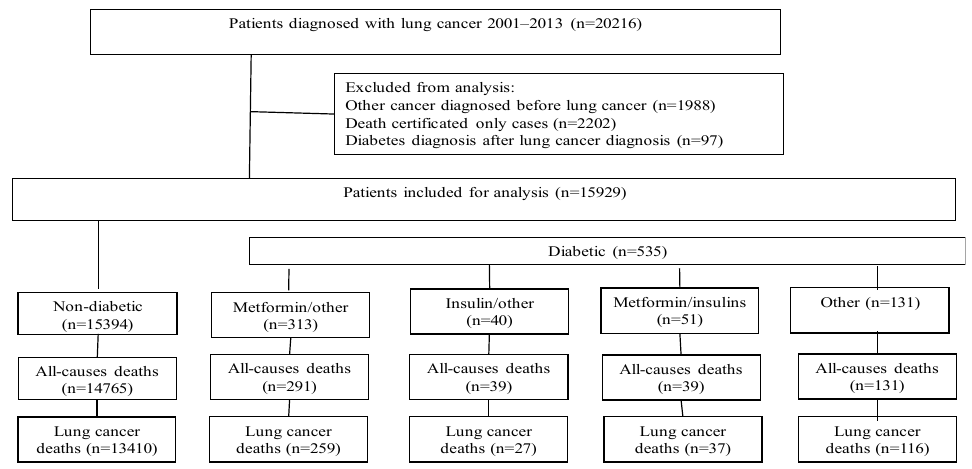
Figure 1. Study flow chart of lung cancer